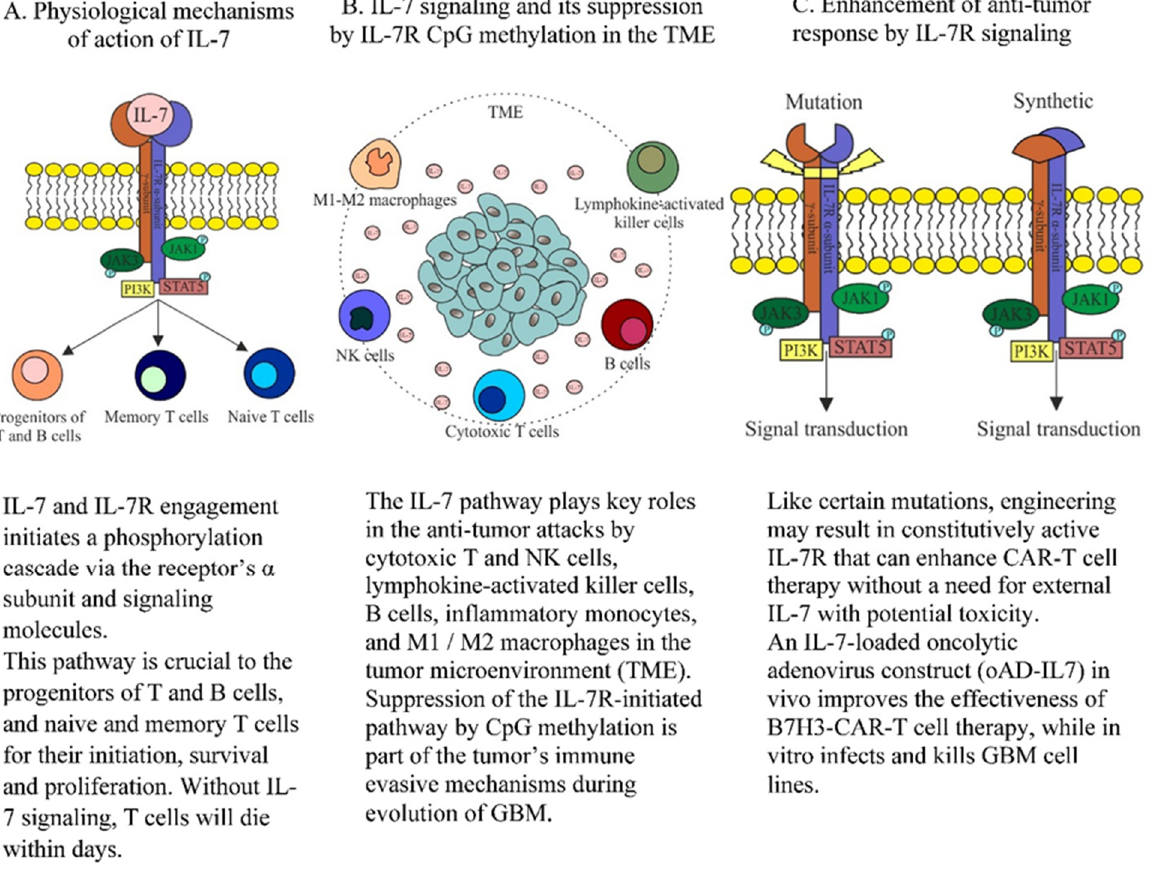
Figure 1. Physiological mechanisms, suppression, and potential therapeutic targeting of the IL-7- initiated pathway in GBM: the figure details ( A ) the normal mechanisms of action [22], ( B ) cell groups affected by epigenetic suppression, and ( C ) therapeutic utility of the IL-7R pathway in GBM [18,19,23].